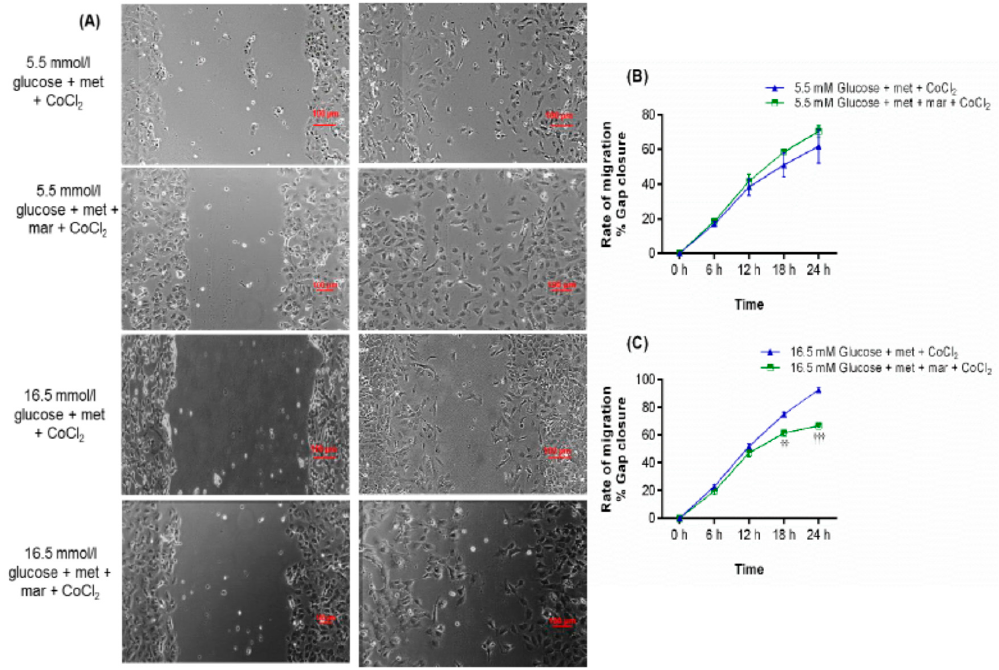
Figure 7. Marimastat antagonizes the effect of metformin on cell migration in HUVEC exposed to hyperglycemia-CoCl 2 . ( A ) HUVEC were incubated with euglycemia or hyperglycemia in the presence or absence of metformin for 24 h. Images were acquired every hour, and three independent biological experiments were performed in duplicate for each condition. The scratch area was measured using NIS Elements software. ( B ) Marimastat had no significant effect on cells treated with euglycemia, metformin and CoCl 2 induction. ( C ) The effect of metformin was inhibited by marimastat treatment. Results are expressed as mean ± SEM and were analyzed using one-way ANOVA followed by LSD, †† p < 0.01, ††† p < 0.001 compared with marimastat treated versus untreated-condition. Scale bar is 100 µm. Key: mar: marimastat; met: metformin.